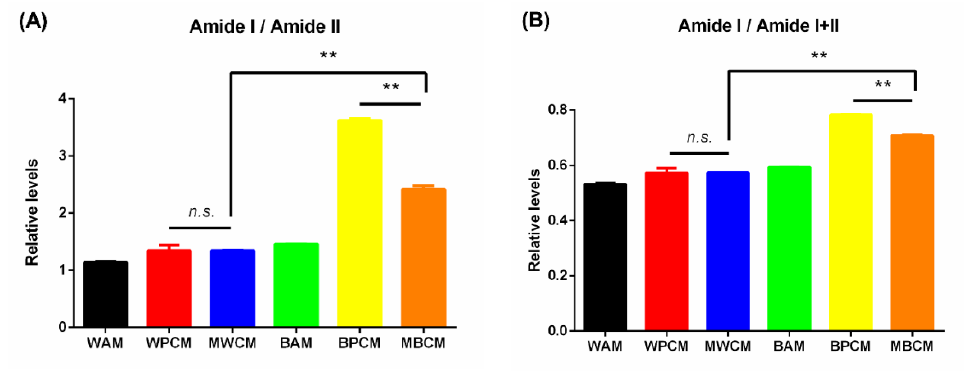
Figure 3. The difference of ( A ) amide I/amide II and ( B ) amide I/amide I + amide II of various adipocyte conditioned media. WAT: white adipocytes; WPA: white preadipocytes; BAT: brown adipocytes; BPA: brown preadipocytes. ** p < 0.01; n.s. , not